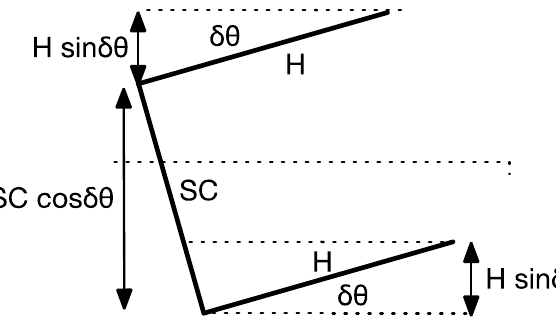
Figure 18. Beam tilt in two-wall mirror